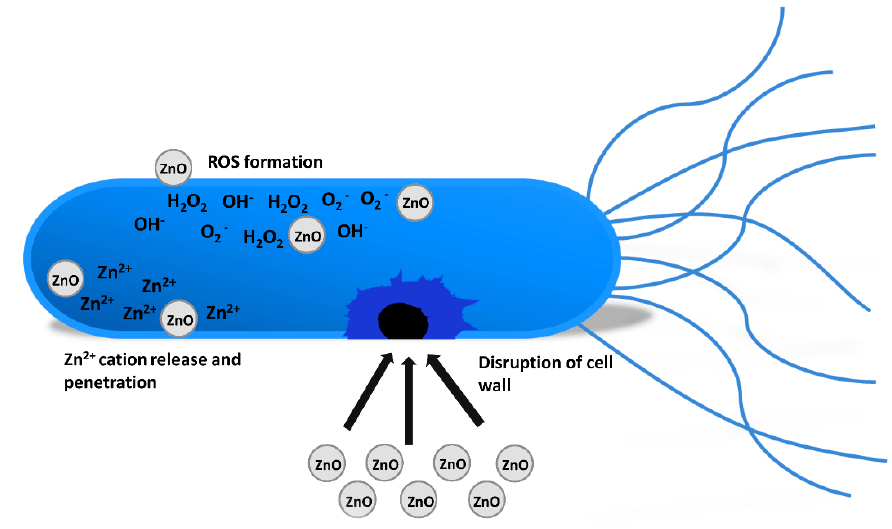
ff erent mechanisms of antimicrobial activity of ZnO Figure 4. Schematic presentation of different mechanisms of antimicrobial activity of ZnO Ps. Figure 4. Schematic presentation of di